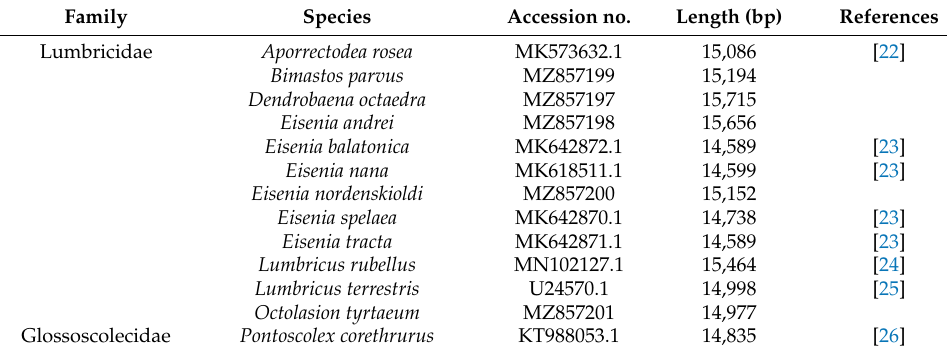
Table 2. Mitogenomes of Lumbricidae and Glossoscolecidae used in phylogenetic analyses. Family